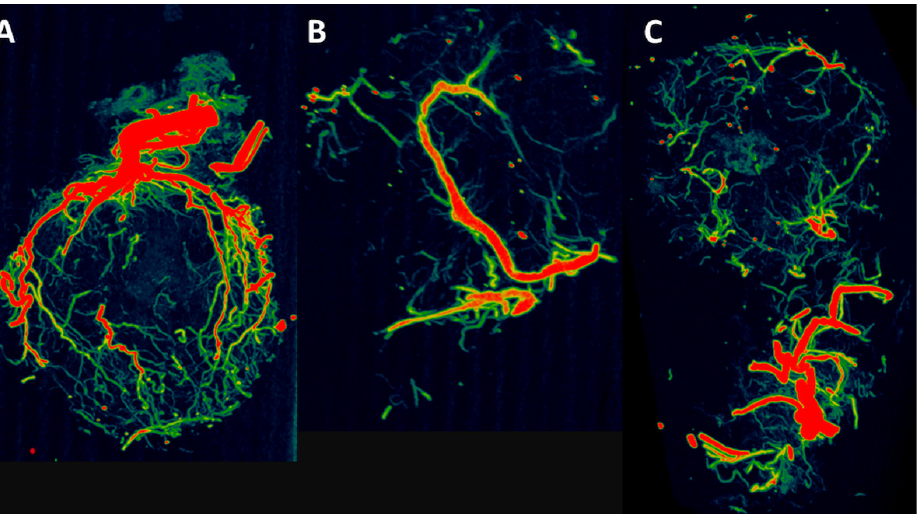
Figure 7. CT reconstructions. After 12 weeks one specimen per group was perfused with Microfil ® and underwent CT analysis. The CTs demonstrate the newly formed vascular network originating from the AV loop and from the periphery. ( A ) Cell-free group. ( B ) T17b EPC group. ( C ) T17b EPC and MSC coimplantation group.